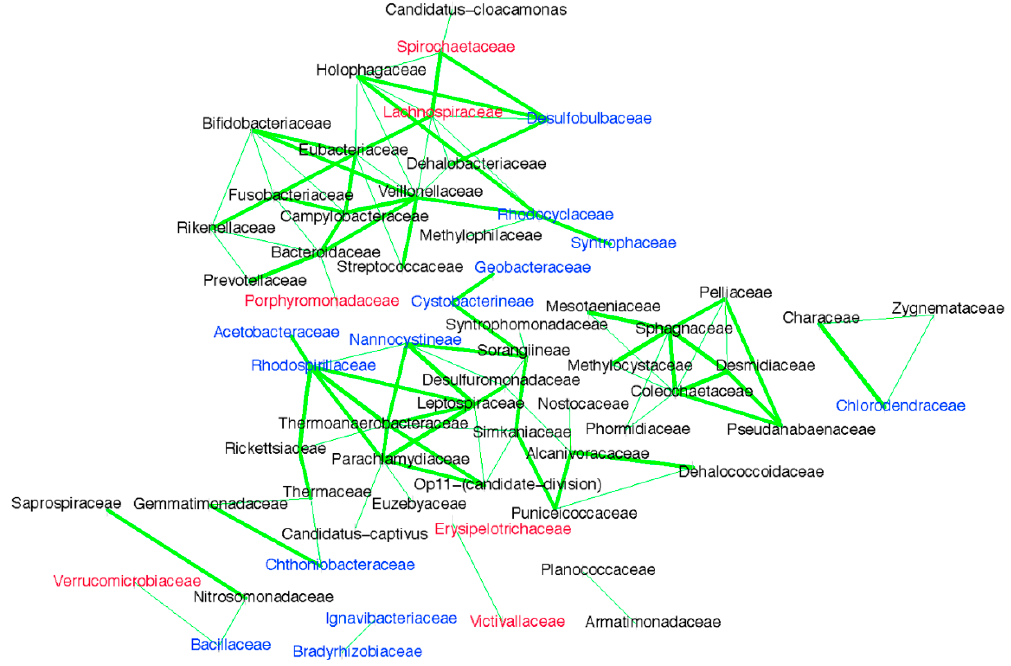
Figure 9. CoNet network analysis of the 63 core families (bacteria in 90% of samples) that co-occur in Sanderson sewage. Green lines indicate co-occurrence of bacterial families with a significant positive Kendall correlation ( P < 0.05 for all correlations adjusted for multiple testing) between the connected taxa. Line thickness reflects the strength of the correlation. Pond-indicator bacteria identified from earlier IndVal calculations are in red (human-associated) and blue (environmental). Number of interactions = 100.